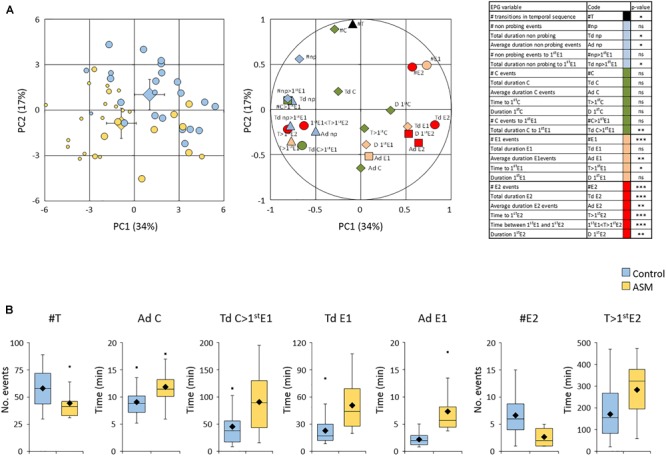
Effect of ASM treatments on Dysaphis plantaginea fundatrigeniae probing behavior. ASM or control was applied three times at 7, 5, 3 dbi. (A) Principal component analysis of EPG data (n = 23 aphids on control-treated plants and n = 27 on ASM-treated plants). Left panel: scatterplots of individual aphids on PC1 vs. PC2. The size of circles indicate on the number of phloem sap ingestion E2 events recorded for each aphid: zero (small circles), only one (medium circles), more than one (big circles). Large diamonds indicate barycenters with confidence intervals of each batch of aphids. Right panel: correlation of EPG variables on PC1 vs. PC2. Variables with significant p-value between the two batches of aphids are indicated with symbols (diamonds: not significant; triangle: p < 0.05; square: p < 0.01; circle: p < 0.001). Table: codes of EPG variables with p-values resulting from the comparison between the two batches of aphids (Mann and Whitney; ns: not significant; ∗p < 0.05; ∗∗p < 0.01; ∗∗∗p < 0.001). (B) Analyses of aphids successfully reaching at least one E2 event (n = 22 aphids on control-treated plants and n = 12 aphids on ASM-treated plants). Focus on significant EPG variables with box plots representing distributions of aphids. Medians, means and outliers are indicated with horizontal lines, diamonds, and squares, respectively.